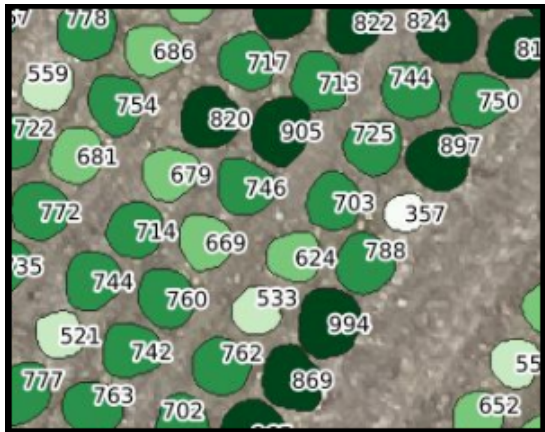
Figure 7. Sizing of each lettuce plant in cm 2 for a sample image patch of L1 field. Each lettuce is overlaid with its predicted mask. The masks’ green colour becomes increasingly darker with the plant